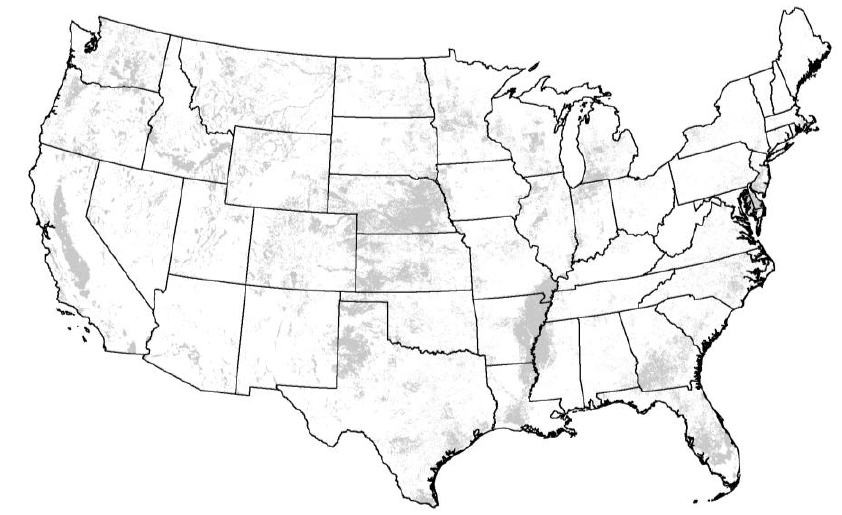
Figure 5. The Moderate Resolution Imaging Spectroradiometer (MODIS) Irrigated Agriculture Dataset (MIrAD-US) showing the spatial distribution of irrigated lands in light gray color identified in a geospatial modeling framework using USDA irrigation statistics for 2002, MODIS annual peak NDVI, and 2001